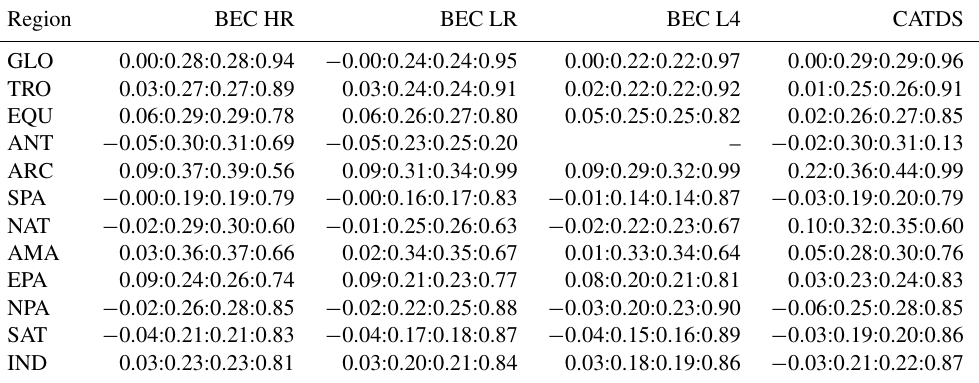
Table 4. Regional statistics of the differences between the SMOS and Argo SSS for the year 2017. For each product and ocean region the mean, standard deviation, root mean square of the difference, and coefficient of correlation r 2 are provided separated by a colon. Region BEC HR BEC LR BEC L4